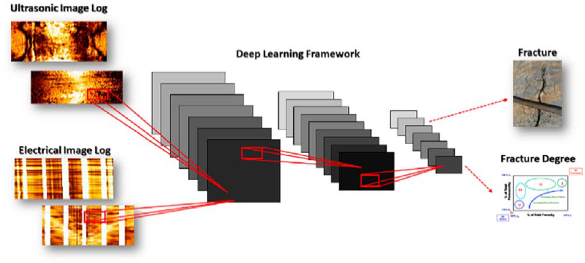
Figure 1. Deep learning framework for the fracture classi fi ca- tion and fracture degree.